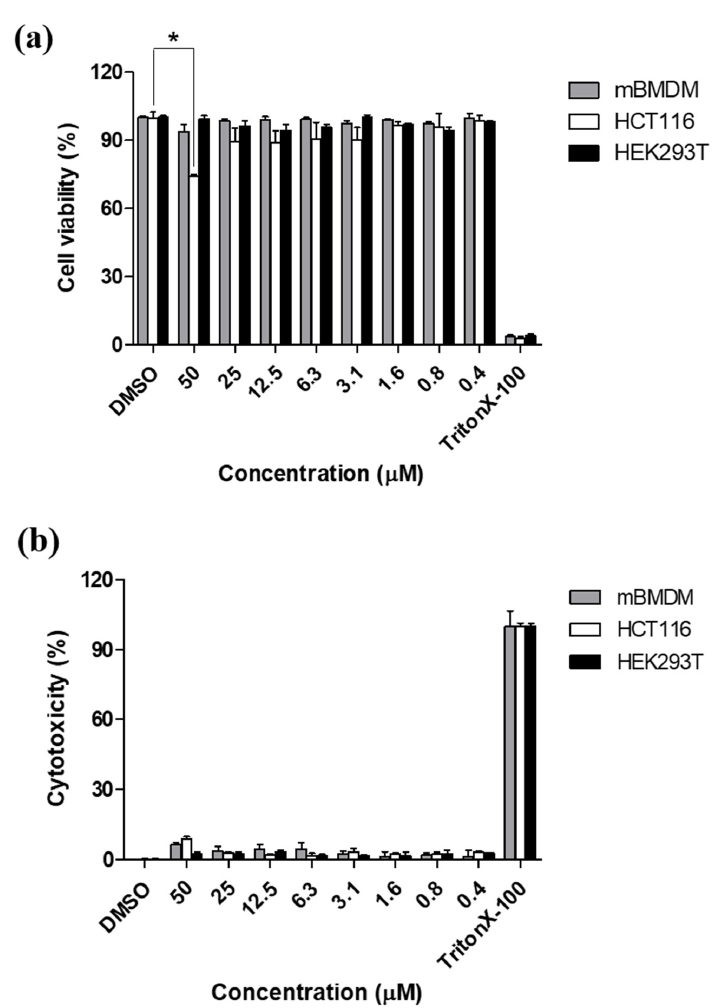
Figure 3. Etamycin e ff ect on cell viability and cytotoxicity. E ff ect of etamycin on viability ( a )